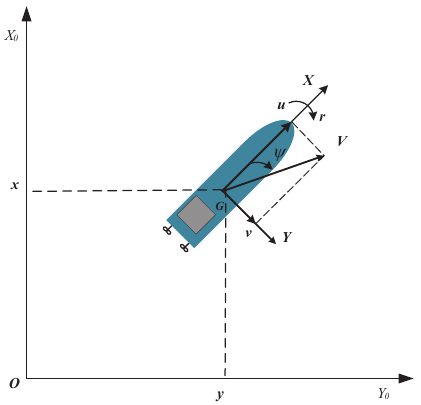
Figure 1. Earth-fixed OX o Y o and body-fixed AXY coordinate frames of a